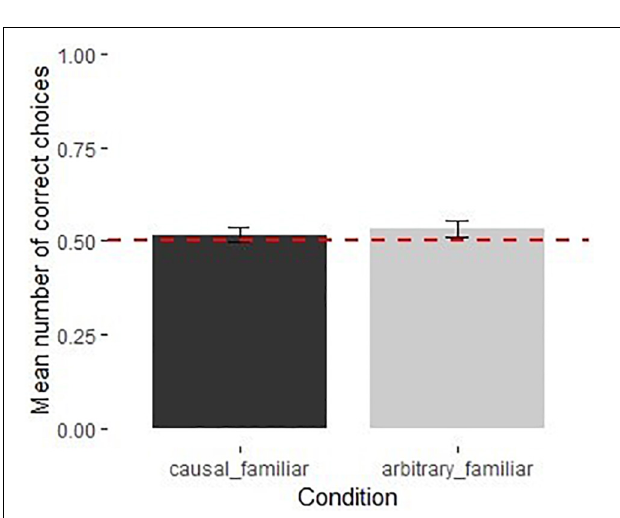
FIGURE 5 | Performance of chimpanzees in the unfamiliar boxes causal condition across sessions in Experiment 3 Phase 1 ( N = 6). Dotted line shows chance level performance ( p = 0.05), error bars represent SE .